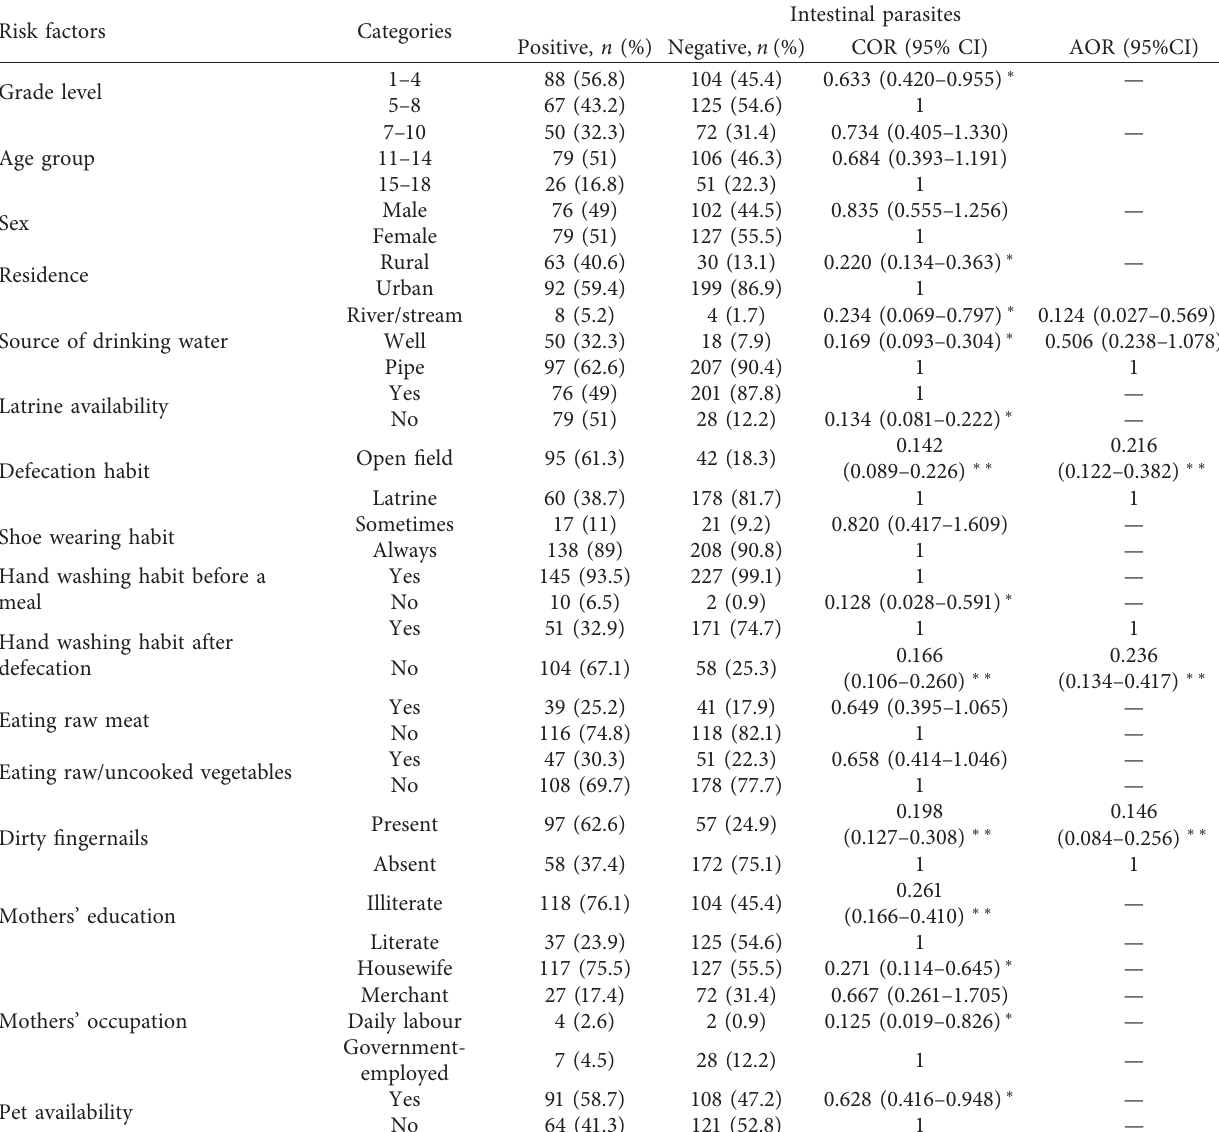
Table 3: Multivariate logistic regression analysis of potential risk factors associated with intestinal parasitic infections (IPIs) in Maksegnit school children,